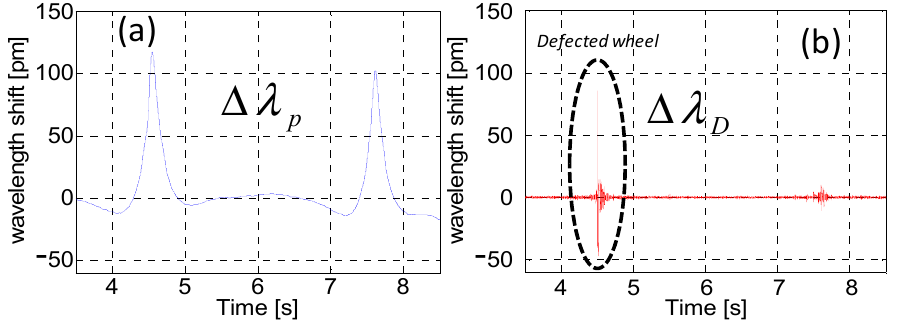
Figure 10. Quasi-static ( a ) and dynamic ( b ) WIM–WILD sensor waveform for a two-axle wagon transit [133].